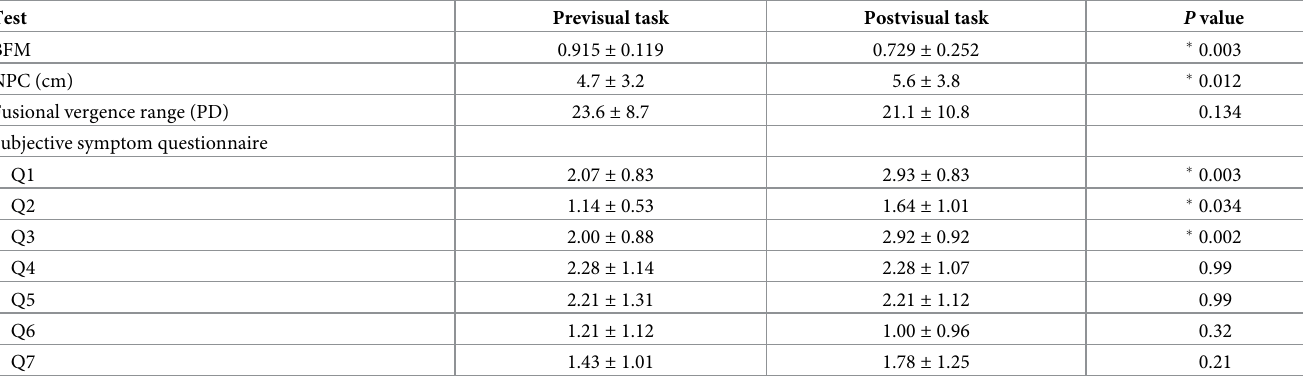
Table 3. Mean results for the intermittent exotropia (IXT)